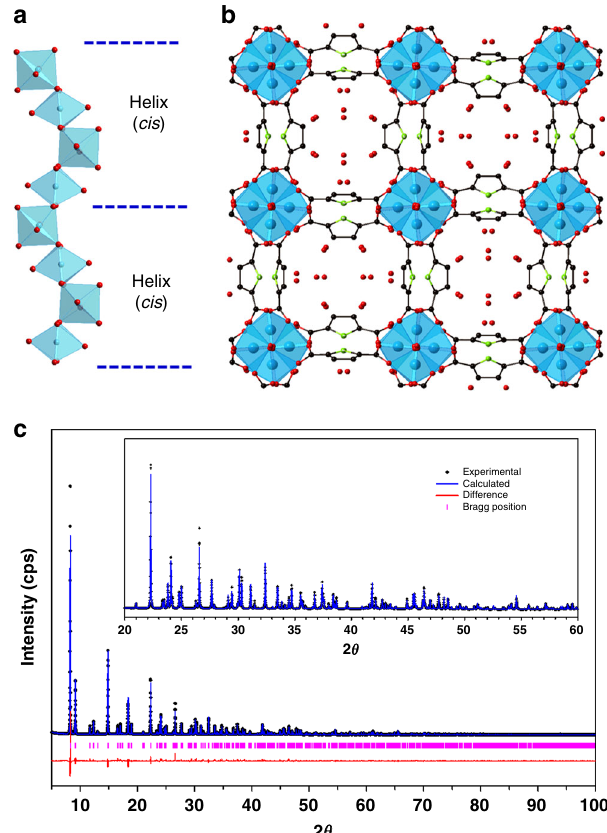
Fig. 1 Crystal structure determination of KMF-1. a Helical chains cis - connected Al octahedra by the corner and coordinated by four carboxylates from the linker along the a axis. b Full crystal structure of KMF-1 in its hydrated form (water positions included) with a square-shaped channel aligned along the c axis. c Rietveld re fi nement of the KMF-1 hydrated structure model. The experimental data are shown in black, simulation in blue, and difference in red below. Allowed Bragg re fl ections are indicated as magenta ticks below. Color scheme: Al, blue; C, black; O, red; N, green (hydrogen atoms omitted for